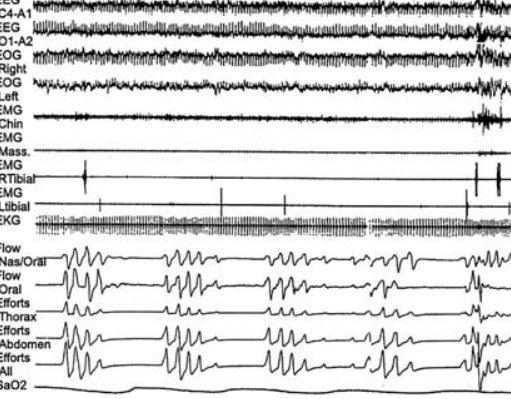
Sleep disordered breathing in acute stroke. 50-year-old patient with mild, unilateral middle cerebral artery stroke (National Institute of Health Stroke Score = NIH = 8) and severe, mainly obstructive sleep apnoea syn- drome (Apnoea-Hy- popnoea-Index = AHI = 47). Sleep study 3 days after stroke: prolonged obstruc- tive respiratory event during NREM sleep with oxygen desatu- ration to 54% is shown (from conven- tional polysomnogra- phy).